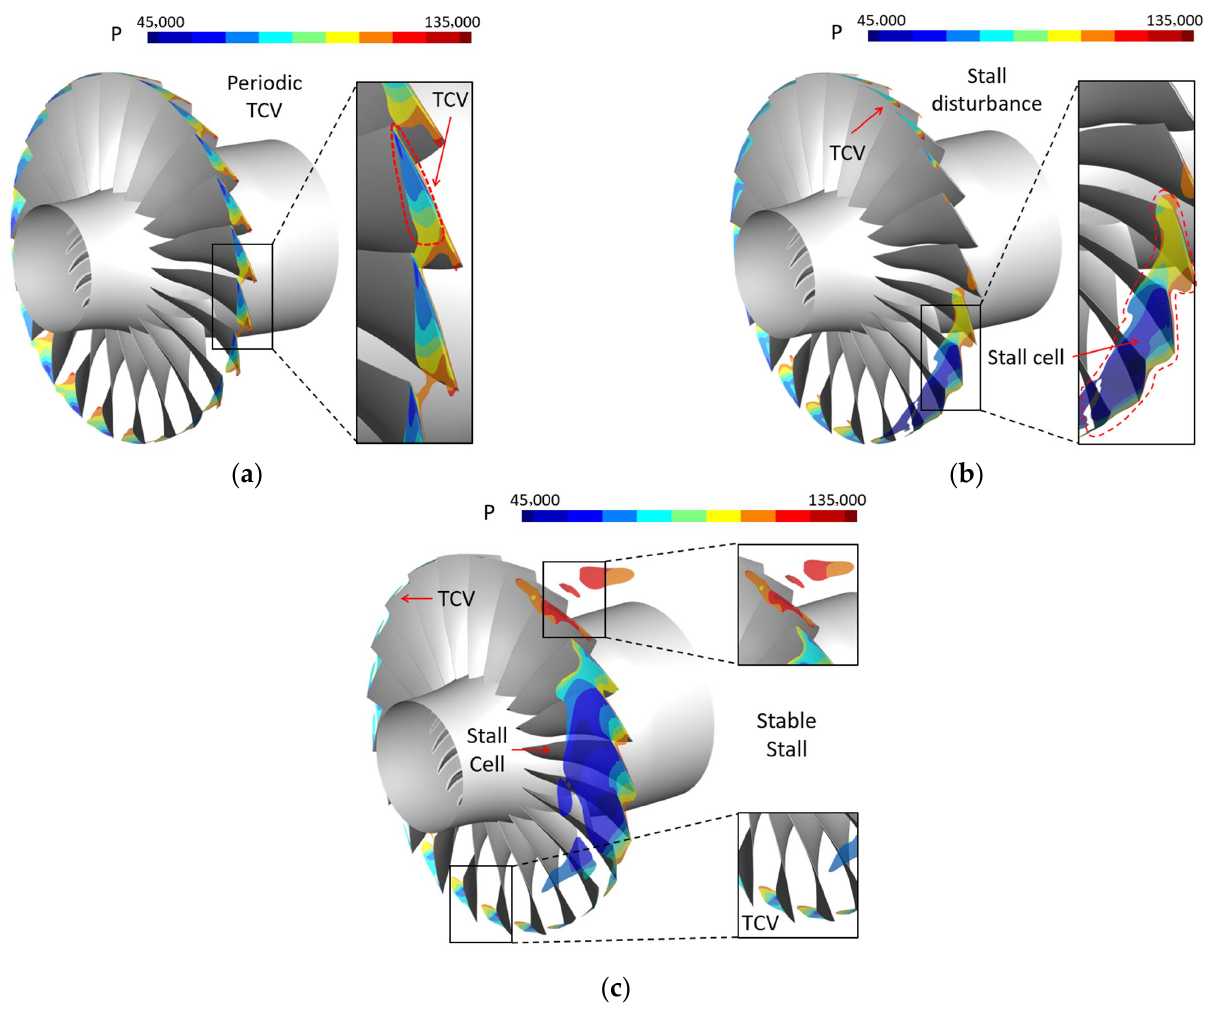
Figure 7. Three-dimensional unsteady vortex features. ( a ) Vortex characteristics of S1 (absolute value of helicity = 30,000). ( b ) Vortex characteristics of S2 (absolute value of helicity = 30,000). ( c ) Vortex characteristics of S3 (absolute value of helicity =